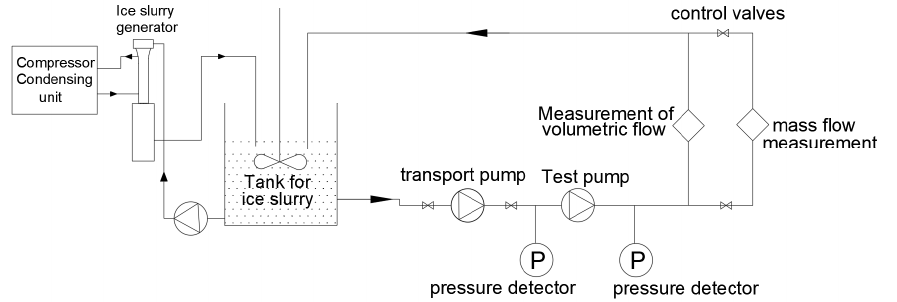
Figure 2. The ice slurry pumping model of a single pump. Table 1. Pump efficiency Q- η data at different ice